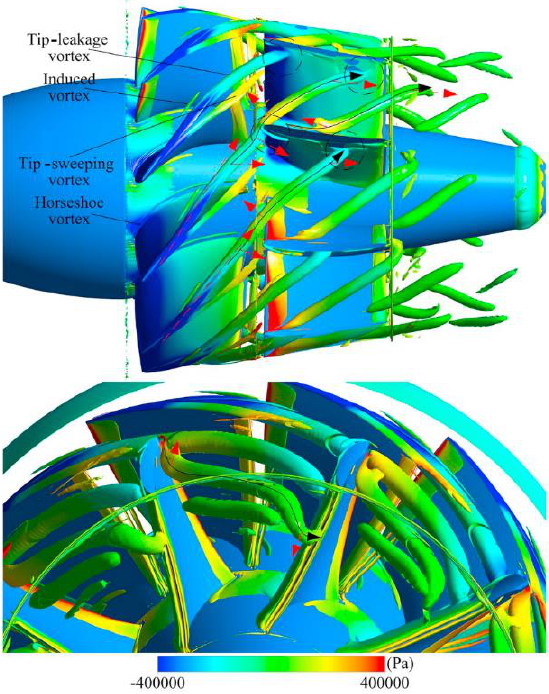
Figure 13. Schematic of the post-swirl pump-jet vortices [59].